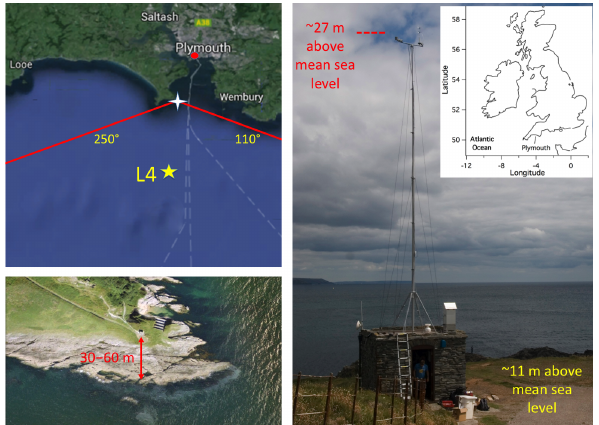
Figure 1. Top left: location of the Penlee Point Atmospheric Ob- servatory (white cross). PPAO is ∼ 6km south-south-west of the Plymouth Marine Laboratory (red dot), ∼ 6km north of the L4 sta- tion (yellow star), and ∼ 18km north of the E1 station (beyond the southerly extent of the map). White dashed lines are commercial ferry routes. Bottom left: a close up map showing the foreshore around the PPAO hut. Right: PPAO with the telescopic mast fully raised. North is up in both maps on the